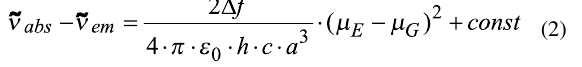
Figure 11: Absorption (top) and fluorescence (bottom) of compound 6c with variable solvent polarity (left to the right: toluene, ethyl acetate, acetone, DMF and DMSO, c ( 6c ) = 10 − 4 M; λ exc = 365 nm, handheld UV